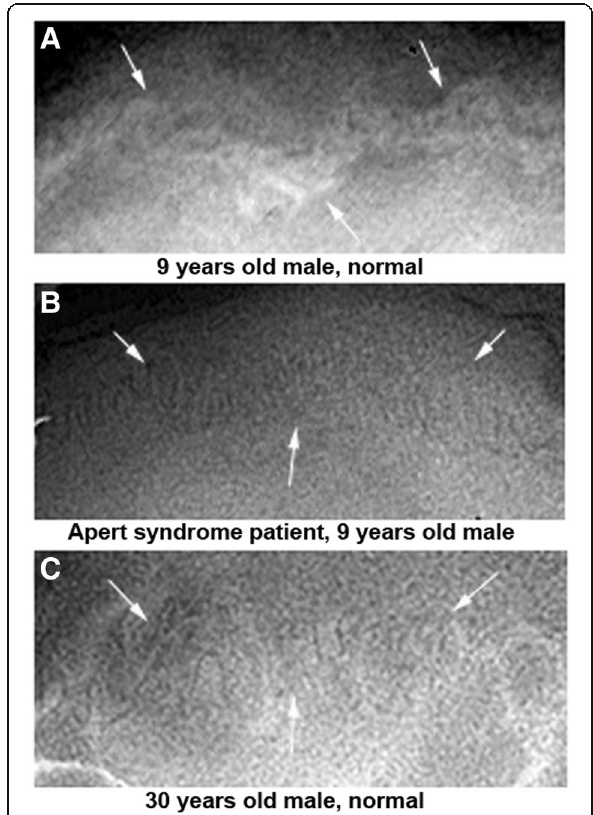
Fig. 7 Coronal sutures in PA X-ray views. a A 9-year-old normal male with still immature coronal suture (arrows). b An Apert syndrome patient, a 9-year-old male, with tightly interdigitated coronal suture (arrows) similar to that of a 30-year-old normal male ( c